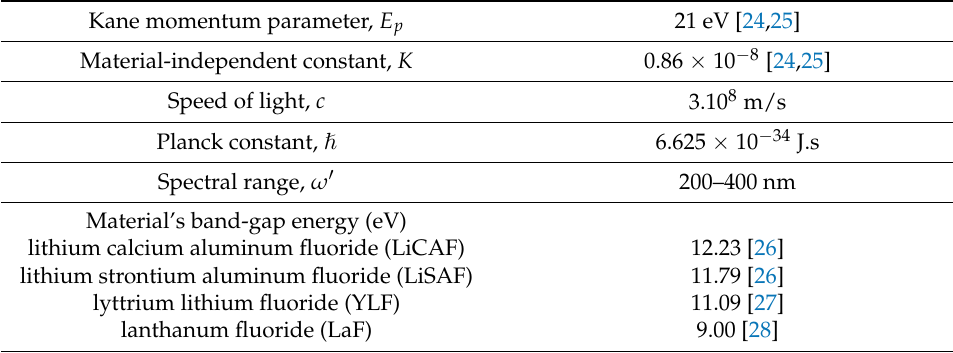
Table 1. Value of parameters used to solve the nonlinear refractive index n 2 using Equation (3).